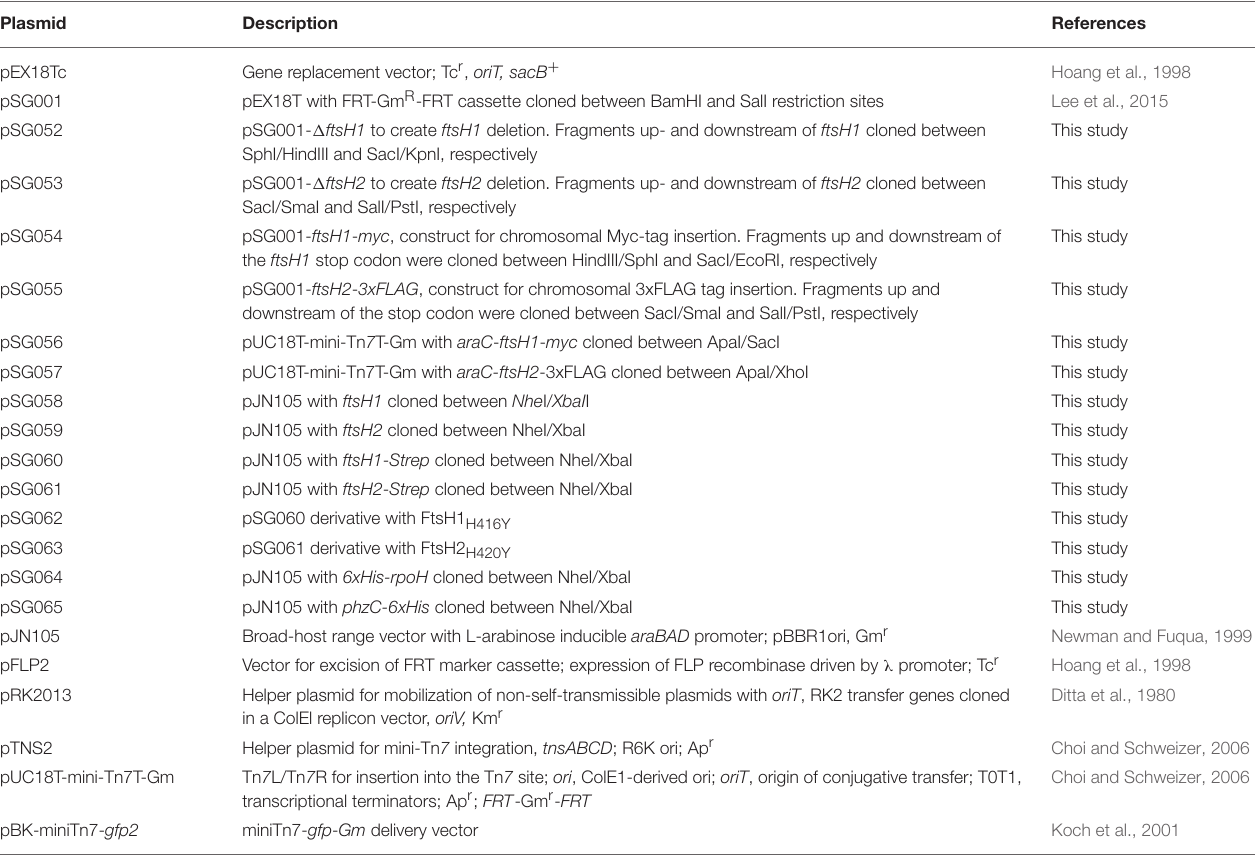
TABLE 2 | Plasmids used in this